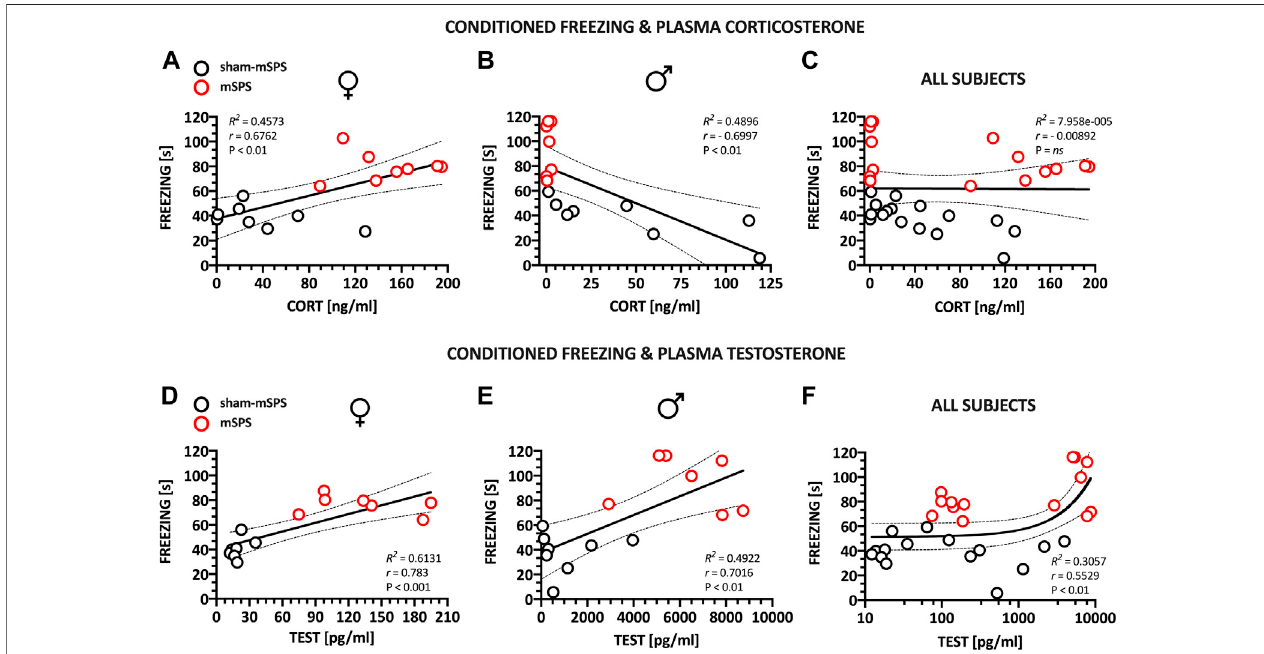
FIGURE 3 | Correlations between behavioral and hormonal responses to trauma in female and male drug-naive mice, two weeks following mSPS. The duration of conditioned freezing was positively and negatively correlated with the plasma levels of corticosterone in female (A) and male mice (B) , respectively. No signi fi cant correlation was observed if the sex factor was collapsed (C) . Conditioned freezing was positively correlated with plasma testosterone in mice of both sexes (D – F). Regressionanalyseswereused todetermine R 2 and statistical signi fi cance. Correlateddatasets were already presented assham and mSPScontrolstreated with saline inthesource Figures2A,B forconditionedfreezing, Figures2C,D forplasmacorticosterone and Figures2G,H forplasmatestosterone.For17 β -estradiol data, see Supplementary Materials. Abbreviations: 17 β -ESTR – 17 β -estradiol, CORT — corticosterone, mSPS – mouse single prolonged stress, TEST – testosterone.